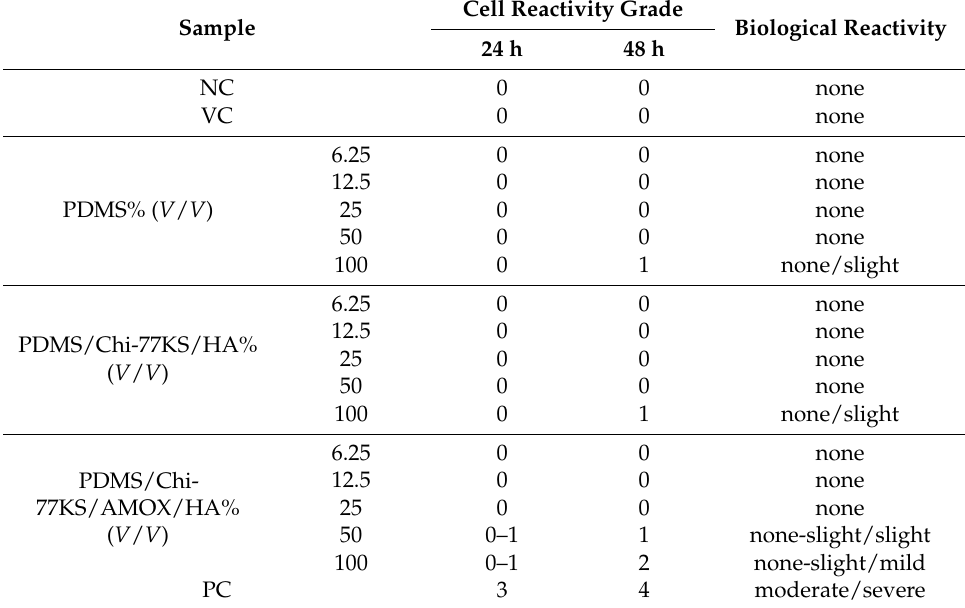
Table 5. Biological reactivity assessment.